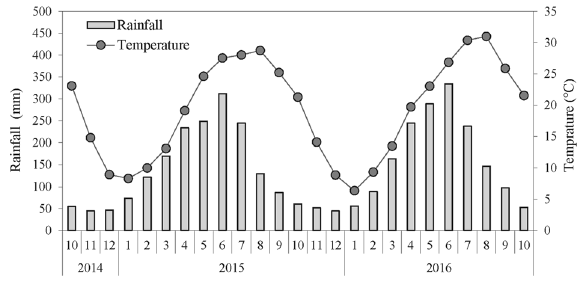
Figure 6. Rainfall and temperature of the experimental site during the